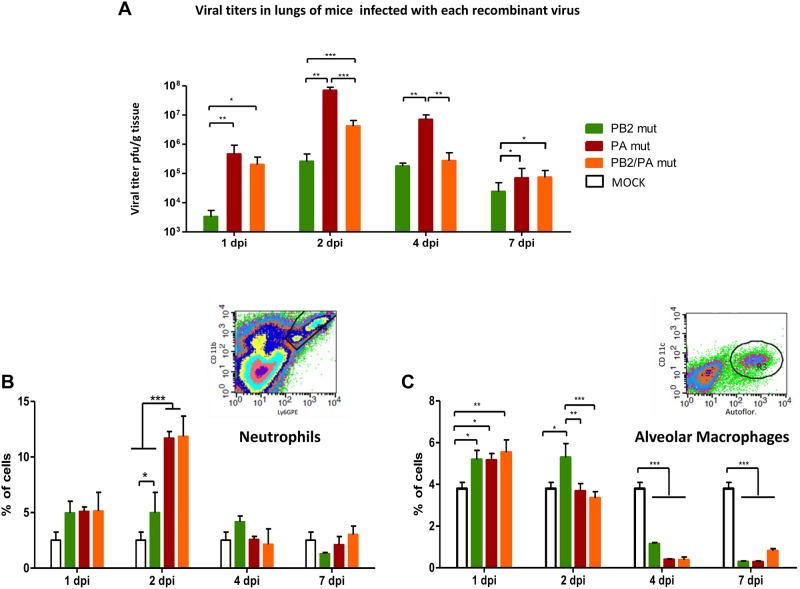
Mutation PA D529N present in a virus from a fatal case increases pathogenicity and induces altered immune response in vivo.Mice (n = 5) were inoculated intranasally with a sublethal dose (103 pfu) of each recombinant virus or PBS (MOCK) as control. At indicated dpi, viral titers were determined in the lungs (pfu/g tissue) (A). Neutrophils (B) and alveolar macrophages (C) were quantified in the lungs (% of cells) at indicated dpi. Significance was determined by Student’s t test (* p <0.05, ** p <0.01, *** p <0.001). Insets show gating information for identification of neutrophil and alveolar macrophage populations.